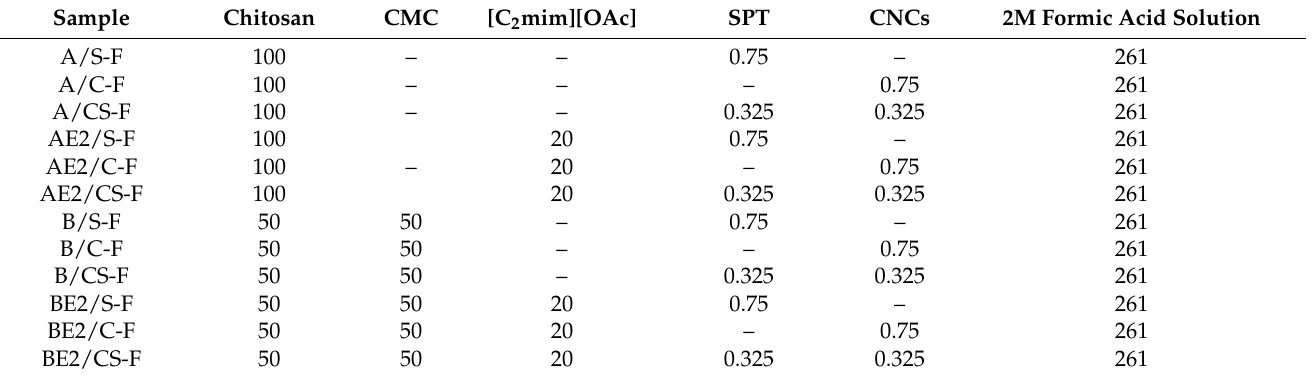
Table 1. Sample codes and compositions (presented as portions by